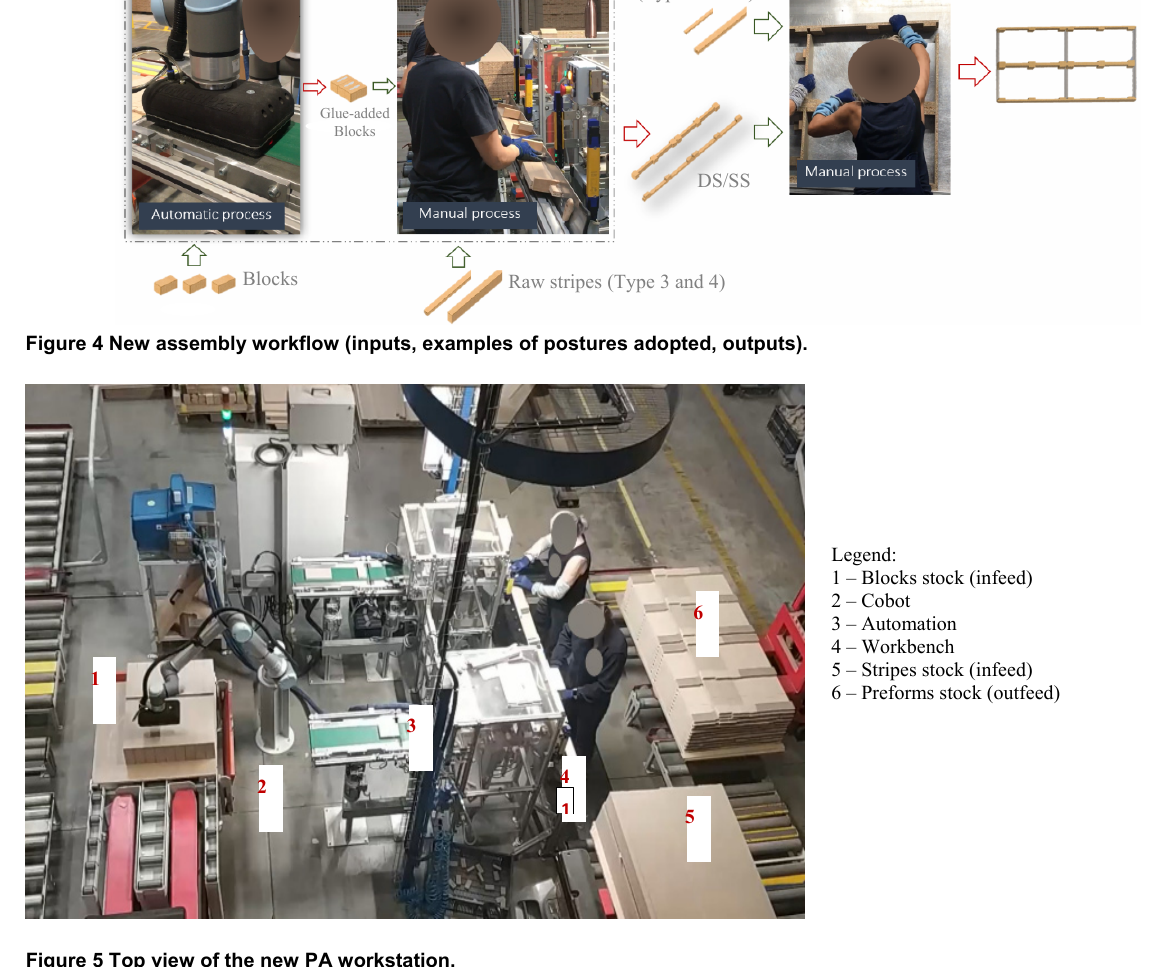
Figure 5 Top view of the new PA